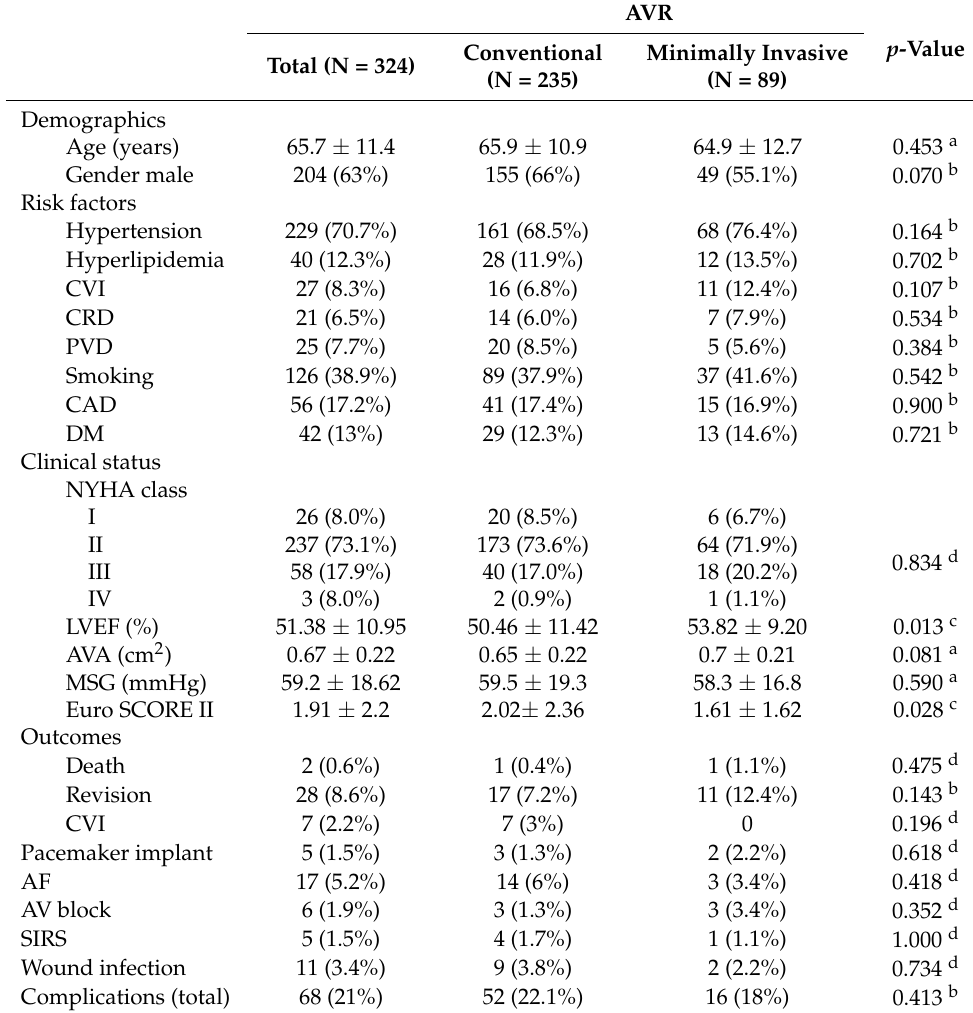
Table 1. Preoperative characteristics, clinical status, and the most important clinical outcomes of conventional and minimally invasive AVR